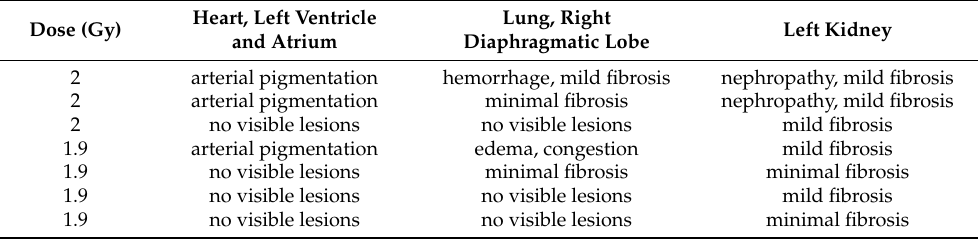
Table 1. Histological findings in Masson’s Trichrome- and H&E-stained slides from the minipig-PBI model. Findings were scored by a board certified pathologist and summarized based on extent of lesion